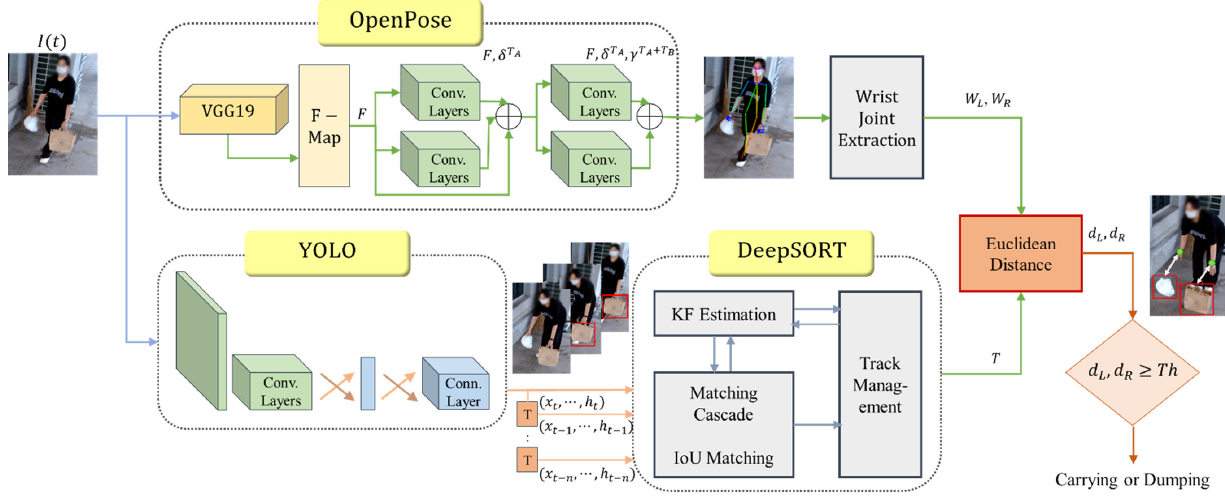
Figure 3. Block diagram of the proposed illegal dumping monitoring system.